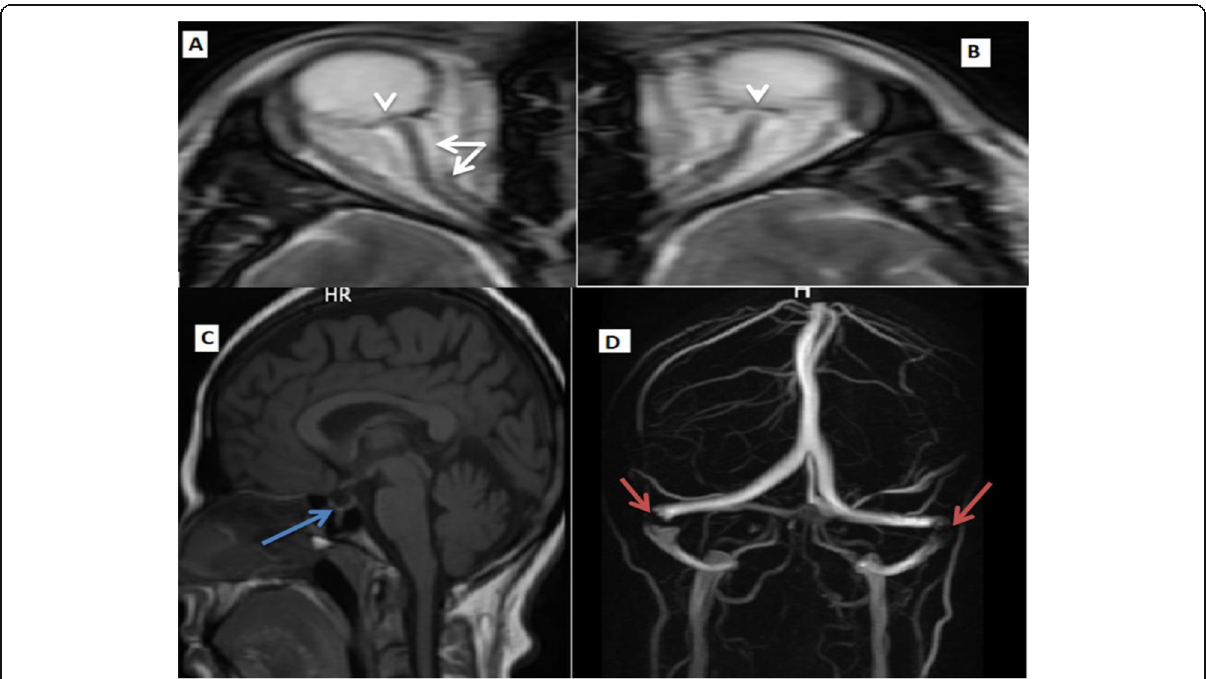
Fig. 4 a – d MRI and MRV of 44 year aged female patient diagnosed with idiopathic increase intracranial tension. a , b Axial T2 scan of both orbits shows tortuosity of right optic nerve and grade 1 distention of right optic nerve sheath (white arrow) with bilateral flattened posterior globe (arrowheads). c A mid-sagittal T1 MRI with no detected pituitary gland inside grade 5 (empty sella) (blue arrow). d Time of flight MRV shows bilateral transverse sinus stenosis (red arrows) combined conduit score was 0 + 1 =